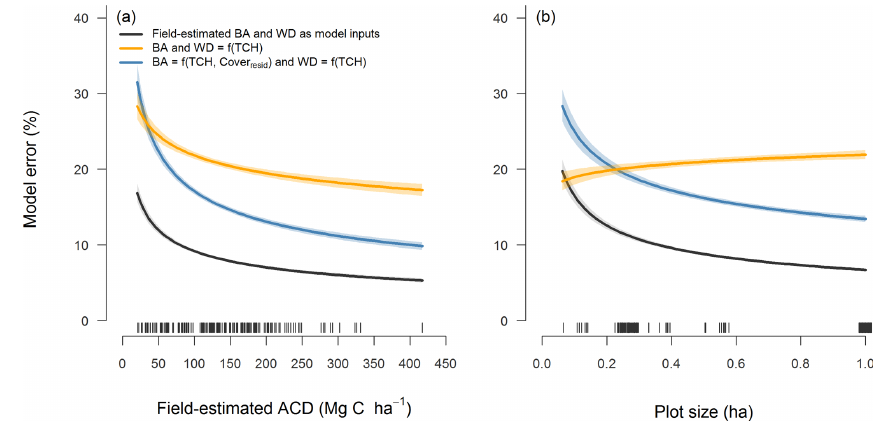
(cid:12) (cid:12)(cid:1) (cid:0)(cid:12) / ACD obs × 100) in relation to (a) field-estimated Figure 6. Model errors (calculated for each individual plot as (cid:12) ACD obs − ACD pred aboveground carbon density (ACD) and (b) plot size. Curves ( ± 95% shaded confidence intervals) were obtained by fitting linear models to log–log-transformed data. Black lines correspond to the regionally calibrated ACD model (Eq. 8 in Sect. 3). Orange lines show model errors when basal area (BA) was estimated from top-of-canopy height (TCH) using Eq. (9). In contrast, blue lines show model errors when BA was expressed as a function of both TCH and canopy cover at 20m aboveground following Eq. (10). Vertical dashed lines along the horizontal axis show the distribution of the data (in panel b plot size values were jittered to avoid overlapping lines).